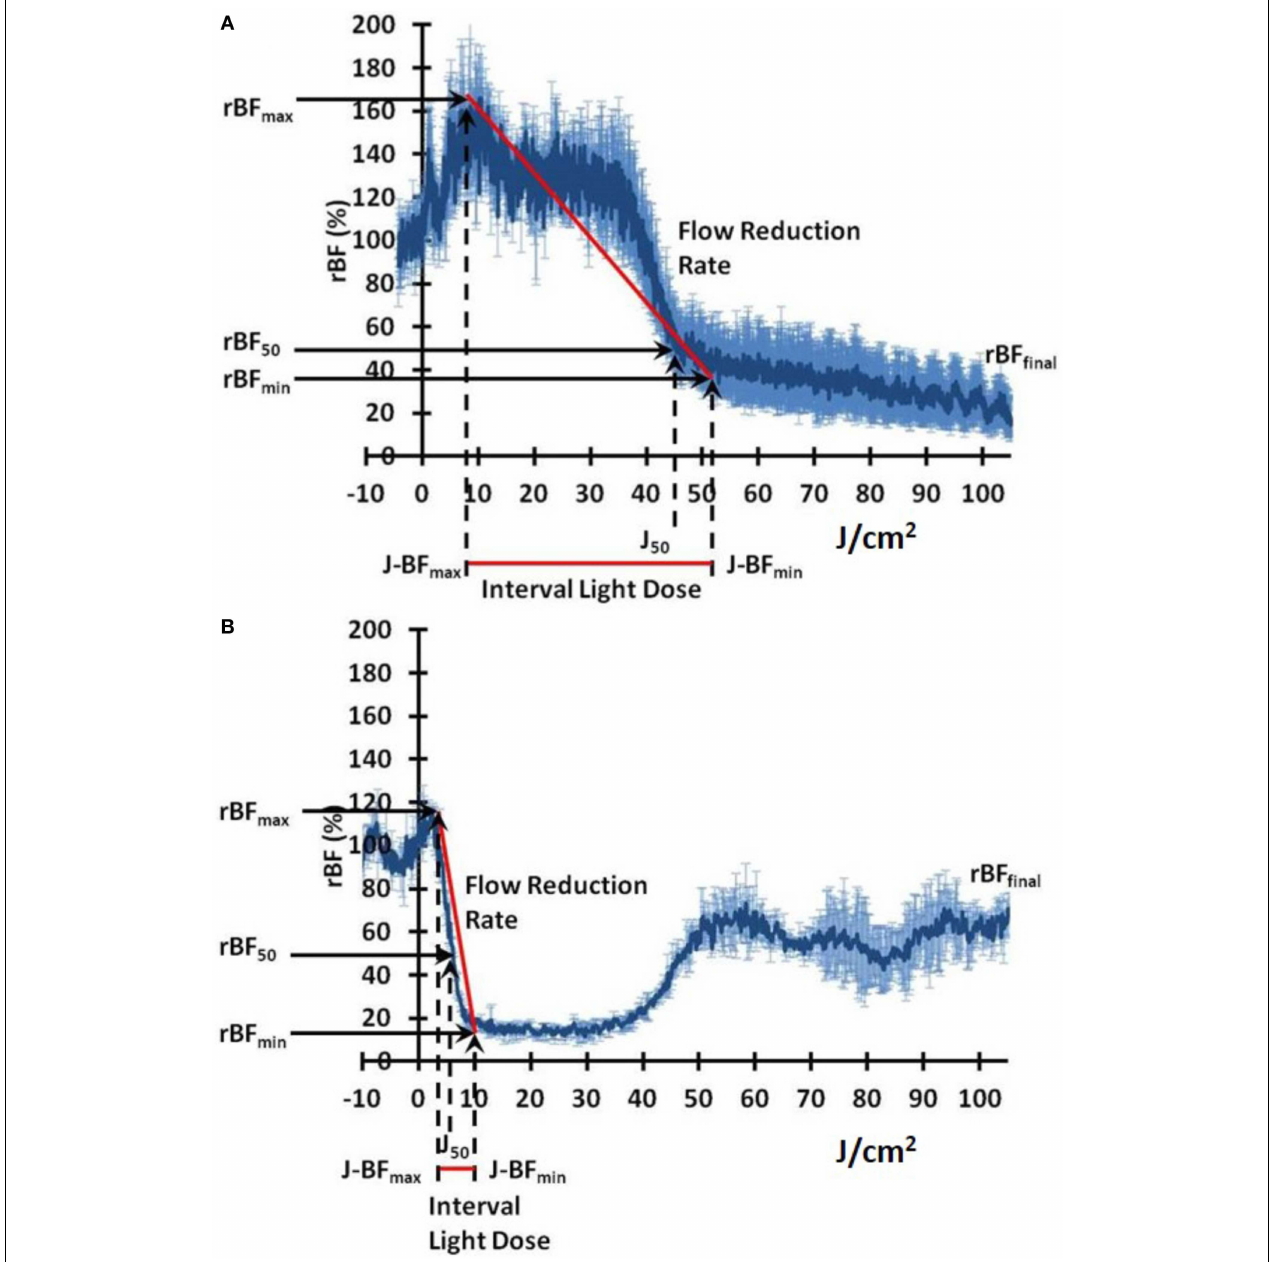
contribute to the photoreaction. Similarly, the low blood flow values would indicate oxygen depletion in tissue. The last two variables in Table 1 ; the Interval Light Dose (ILD) and the Flow Reduction Rate (FRR) are similar to previously reported param- eters by Yu et al. [37]: the ILD indicates the light dose between the first maximum blood flow and the first minimum blood flow values, and the FRR indicates the slope between these max